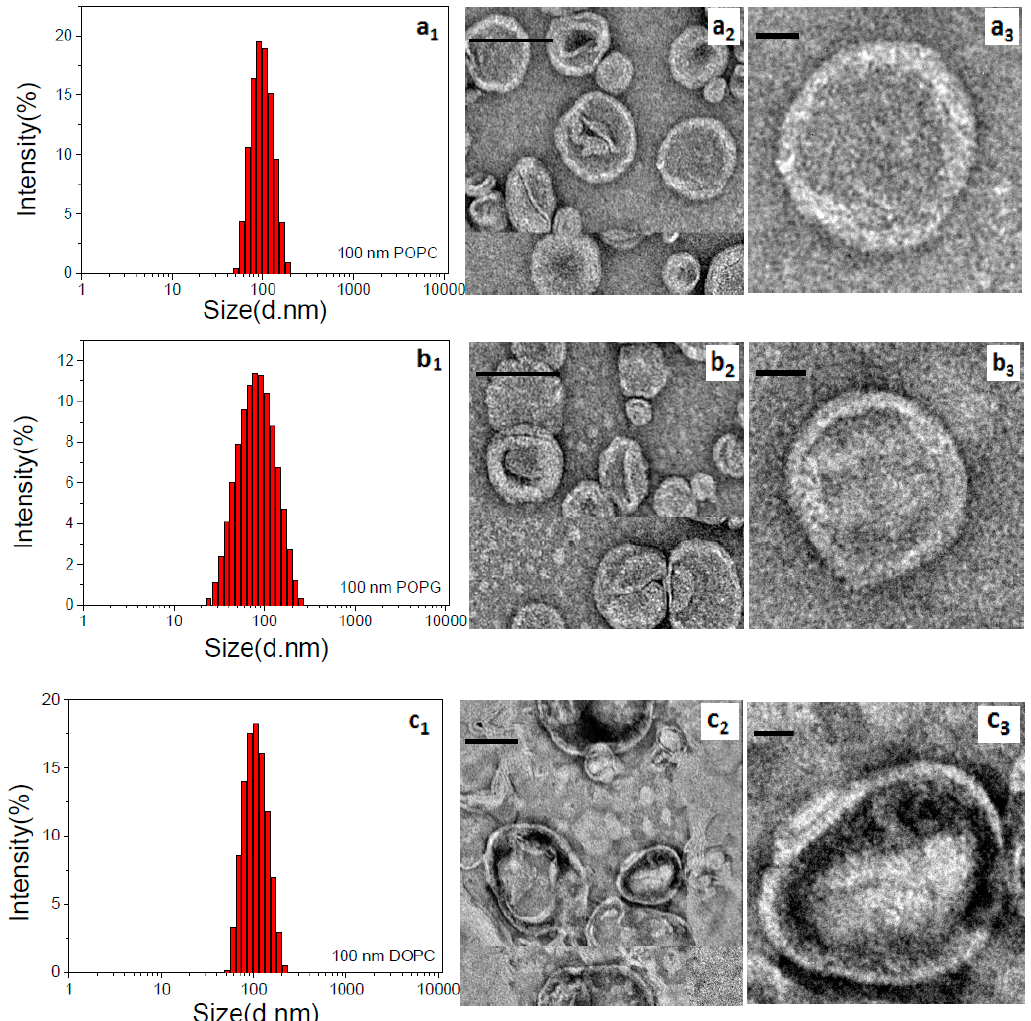
Figure 3. DLS data and Negative-Stain TEM images of lipid vesicles prepared by extrusion ( a ) 100 nm POPC; ( b ) 100 nm POPG; ( c ) 100 nm DOPC.